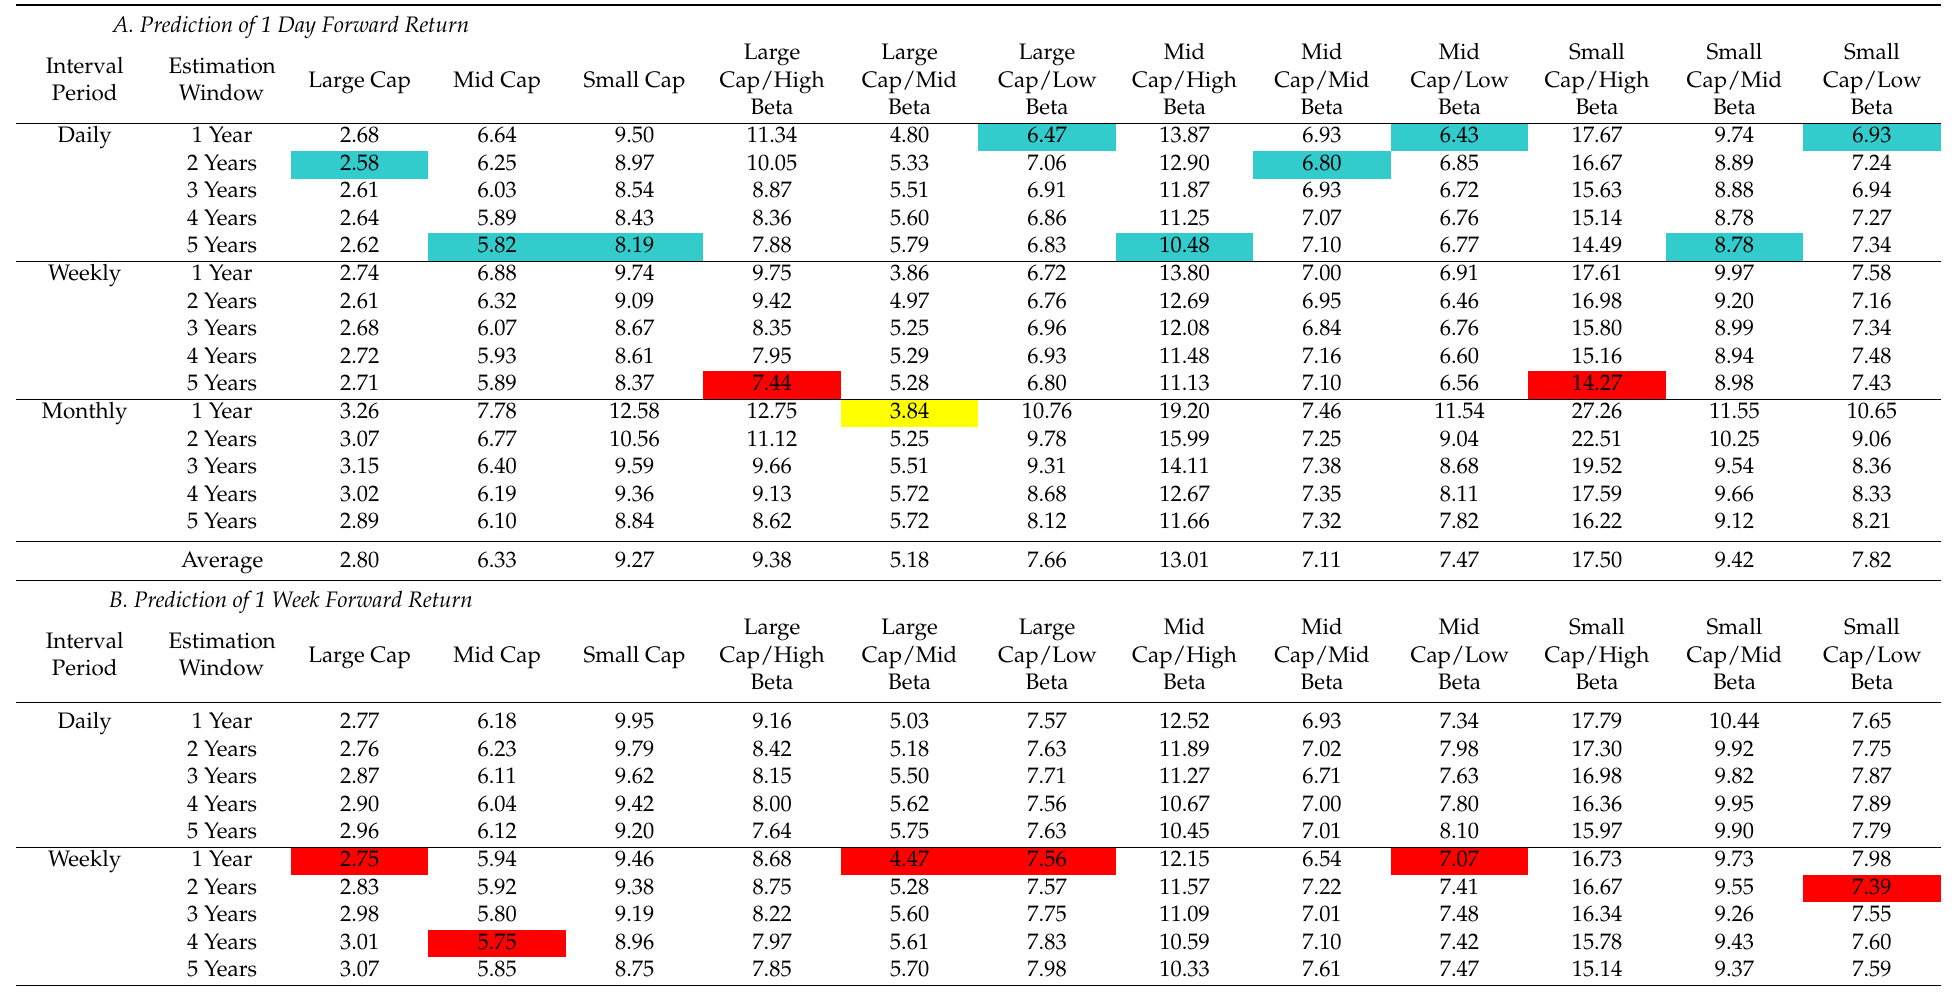
Table 1. Annualized Tracking Error of Actual Portfolio Return vs Beta Estimated Portfolio Return—All